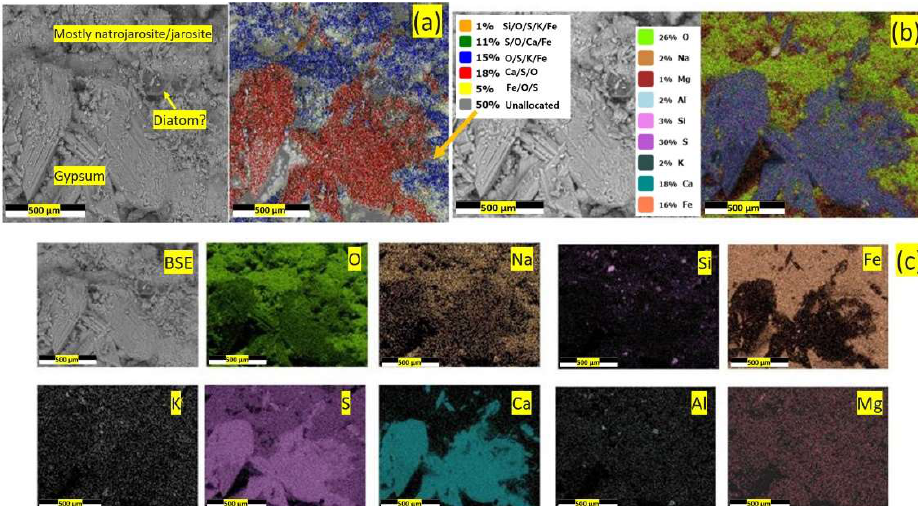
Figure 22. BSE image and overlayered phase mapping ( a ), overlayered elemental mapping ( b ) and individual elemental mapping ( c ) in one of the samples collected from Stefføya. The insets in ( a , b ) are the relative percentage of the different phases and elements, respectively, detected in the selection area. Gypsum formation in association with mostly natrojarosite is evident. Remnants of weathered diatoms are also identified in the microscopic investigation.